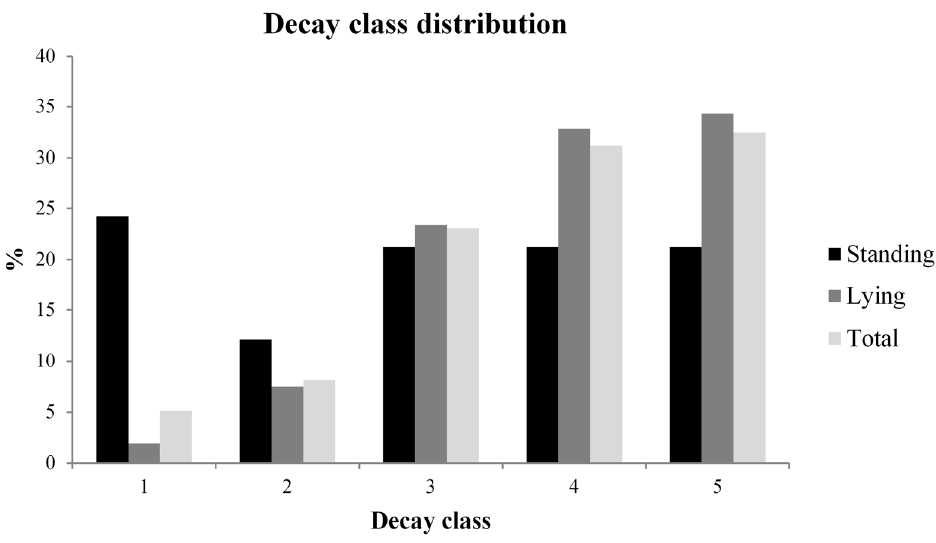
Figure 10. Wood decay classes percentage distribution.